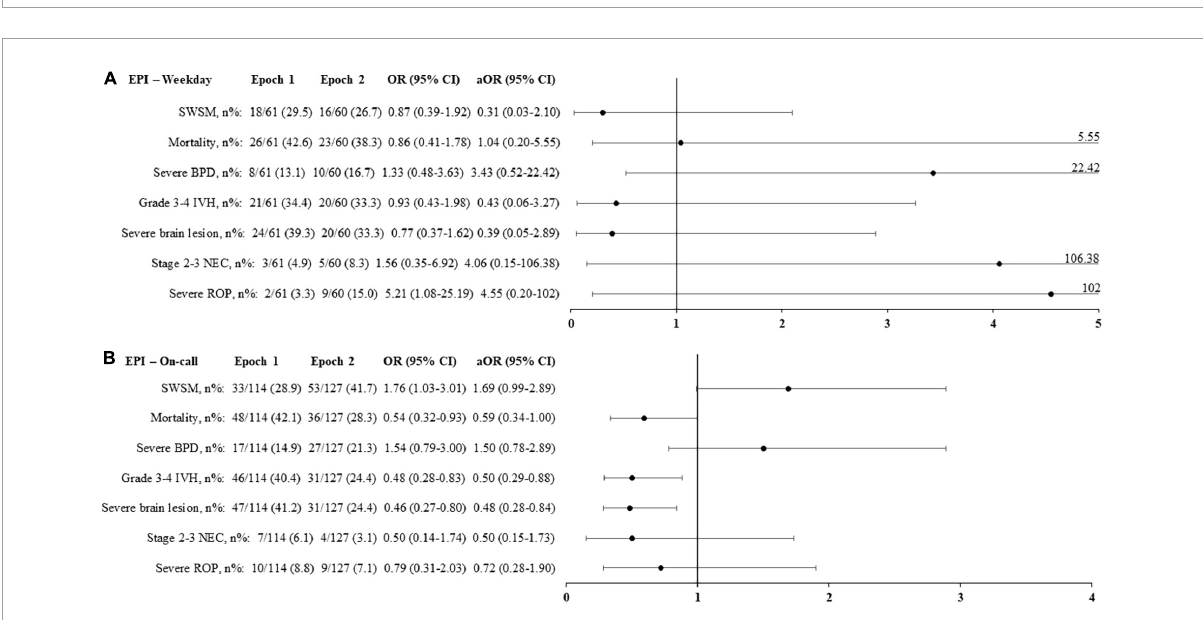
FIGURE5 Primary and secondary outcomes according to the epochs and the period of birth [Weekday: (A) , On-call: (B) ] in extremely premature infants (born < 27 weeks’ gestational age). Adjusted odds ratio (aOR), weighted by the propensity score, and their 95% confidence interval (95% CI) shown of the figure are expressed vs. Epoch 1. On-call: defined as birth in weekdays between 6.30 p.m. and 8.30 a.m., in weekends and public holidays. EPI, extremely premature infants; SWSM, survival without severe morbidity; BPD, bronchopulmonary dysplasia; IVH, intraventricular hemorrhage; NEC, necrotizing enterocolitis; ROP, retinopathy of prematurity.